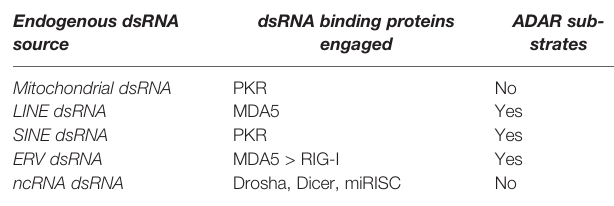
TABLE 1 | Indication of the major endogenous sources of dsRNA, their privileged dsRNA-binding proteins, and their propensity to be deaminated. Endogenous dsRNA